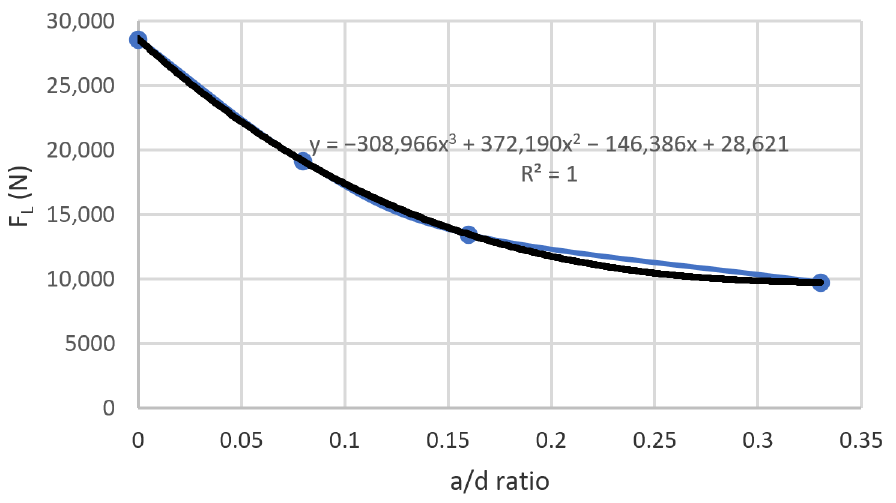
Figure 4. General behavior at the proportional limit.